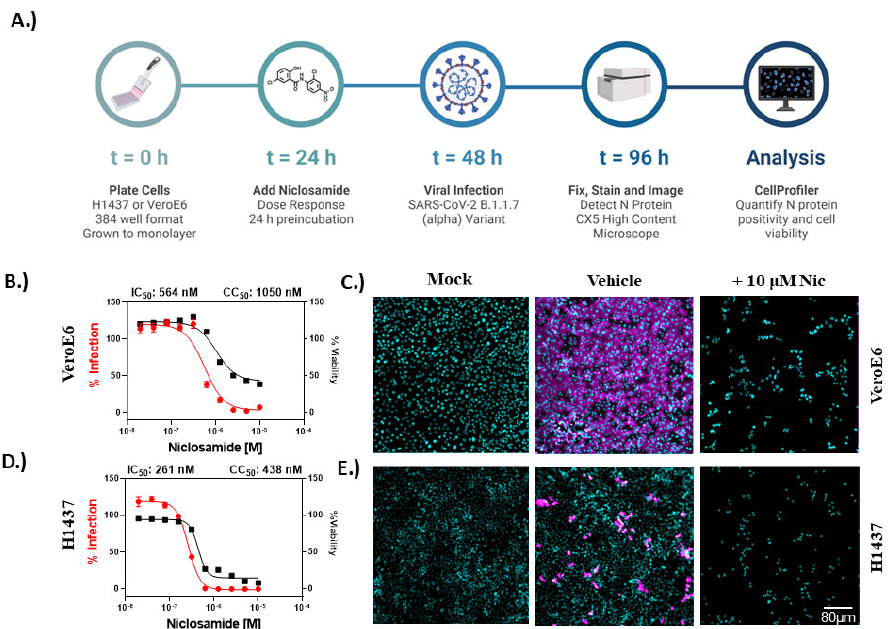
Figure 1. Niclosamide is toxic at antiviral concentrations after long-term exposure. ( A ) Workflow for high content anti-SARS-CoV-2 bioassay screening to determine infection inhibition and cytotoxicity. ( B ) 10-point, 2-fold dilution concentration–response curves for VeroE6 cells infected with B.1.1.7 variant at MOI = 0.1 for 48 h. ( C ) Representative images for mock, vehicle, and 10 µ M niclosamide- treated (infected) VeroE6 cells. ( D ) Concentration–response curves for H1437 cells infected with B.1.1.7 variant at MOI = 1 for 48 h. ( E ) Representative images for mock, vehicle, and 10 µ M niclosamide- treated (infected) H1437 cells. Data points in concentration–response curves represent mean ± SEM for n = 10 replicates per condition. Curve fitting was performed in GraphPad Prism 9 using a semi- log 4-parameter variable slope model. Percent infection is shown using red curves, while percent viability is shown in black. Images were captured at 10 × magnification, and the overlays were generated in ImageJ such that cyan = nuclei and magenta = SARS-CoV-2 N protein (uniform scale barb= 80 micrometers).